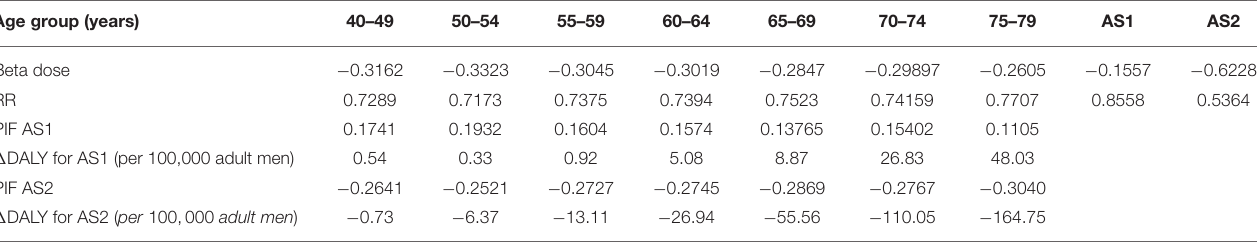
TABLE 4 | Dose–response parameters and estimated net health impact ( 1 DALY) associated with intake of Se for the prevention of prostate cancer through the consumption of rice in alternative scenarios 1 and 2 in different age groups.